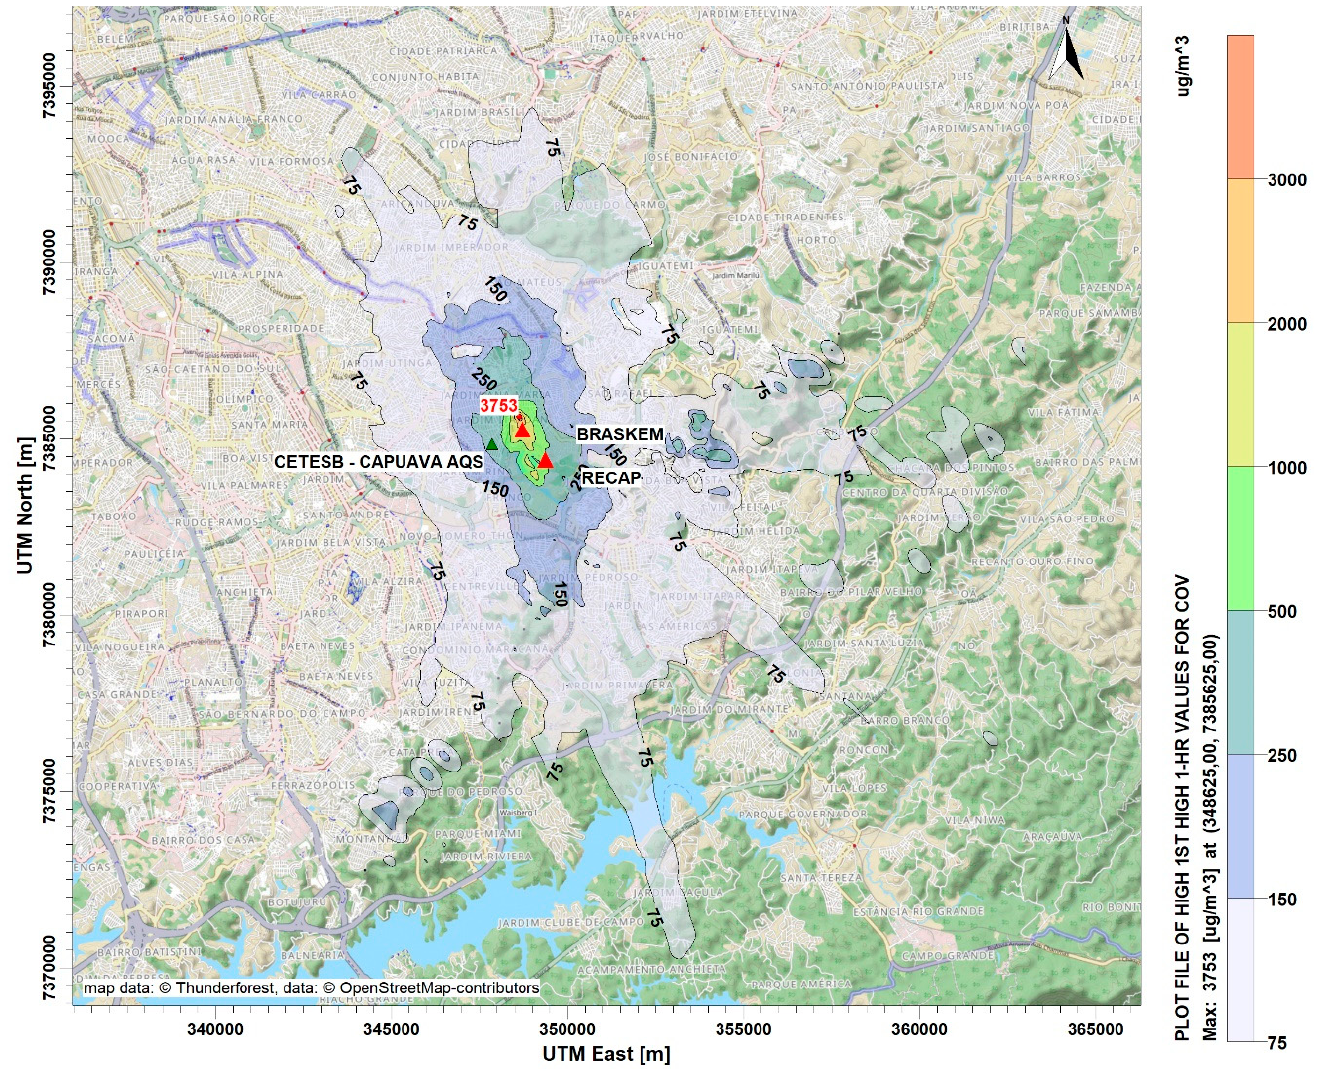
Figure 7. The maximum concentration of 1 h average (µg m − 3 ) of VOC in the affected area during the CPC maintenance period.